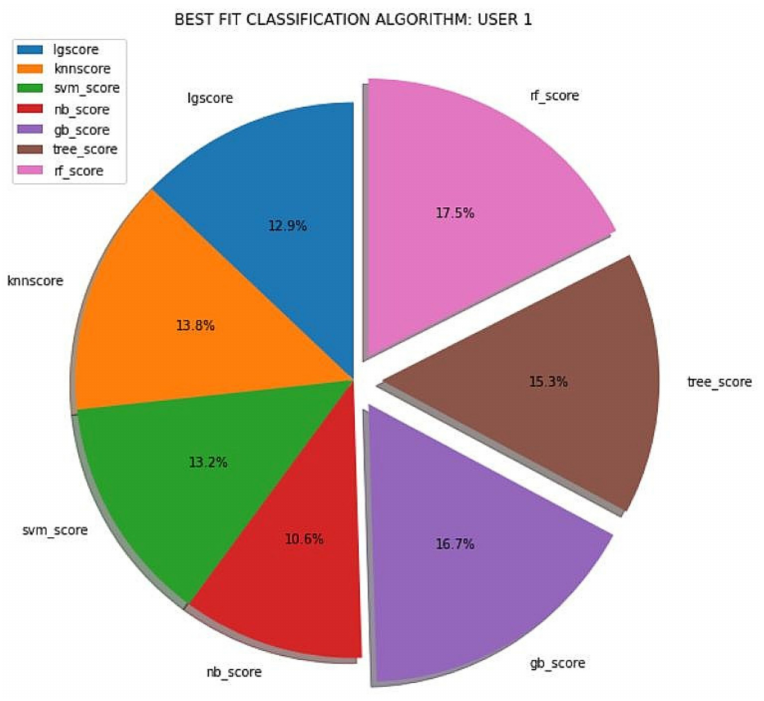
Figure 6. Recommended Classifiers.